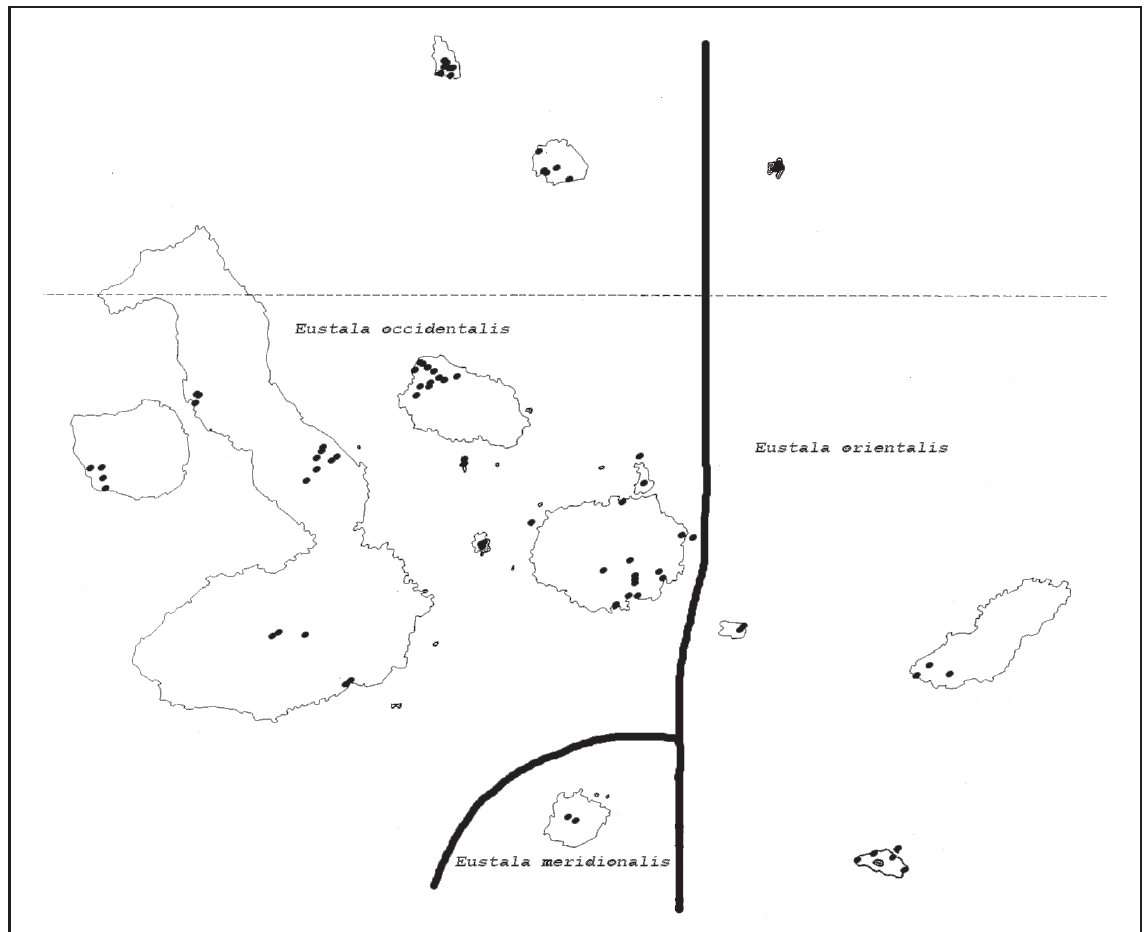
Fig. 7. Distribution map of Eustala occidentalis sp. nov., Eustala occidentalis sp. nov. and Eustala meridionalis sp.